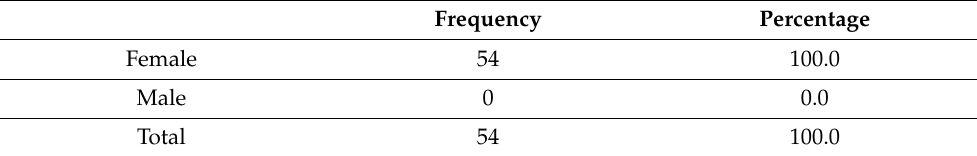
Table 1. Frequency table for gender.